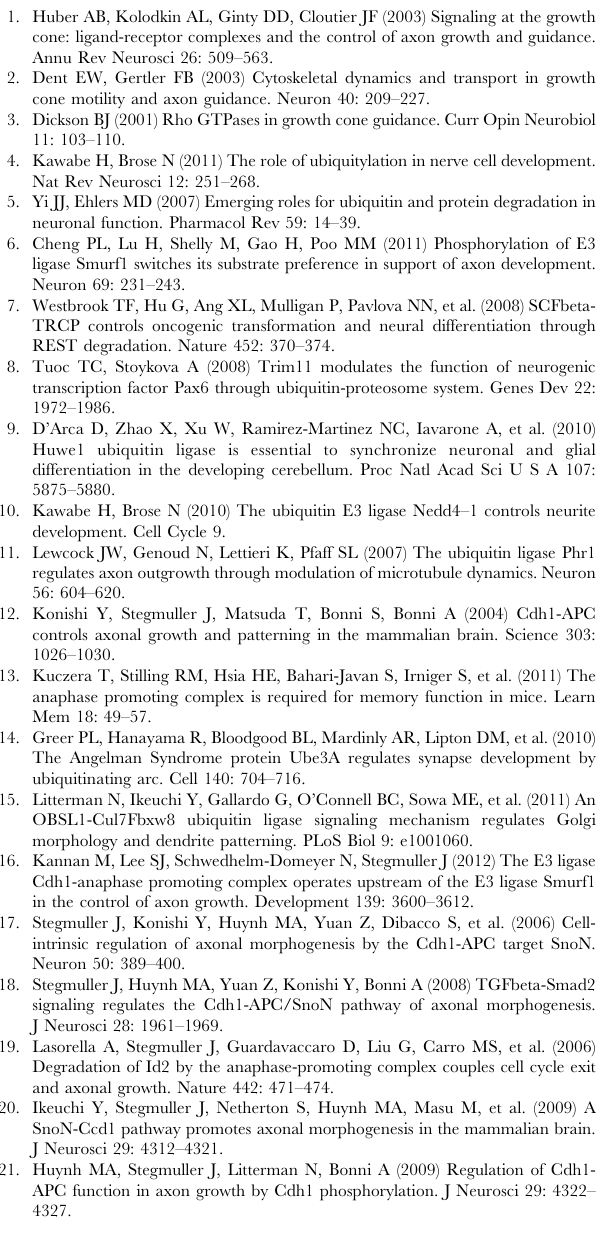
Figure S3 Quantification of processes in the developing cerebellar cortex. A. Quantification of thin (normal) processes and short, thick processes in control, p250GAP knockdown and p250GAP/Smurf1 double-knockdown conditions. A total of 1200 processes were counted (ANOVA, ***p , 0.0001, values indicate mean +